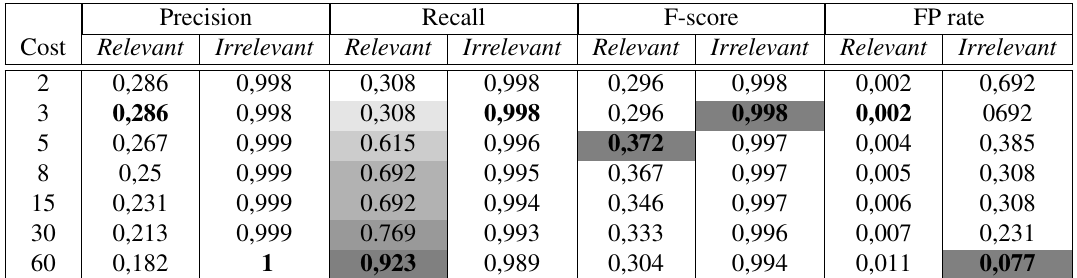
Table 13: Results of a cost-sensitive BN classifier using different cost values for category T. Precision Recall F-score FP rate Cost Relevant Irrelevant Relevant Irrelevant Relevant Irrelevant Relevant